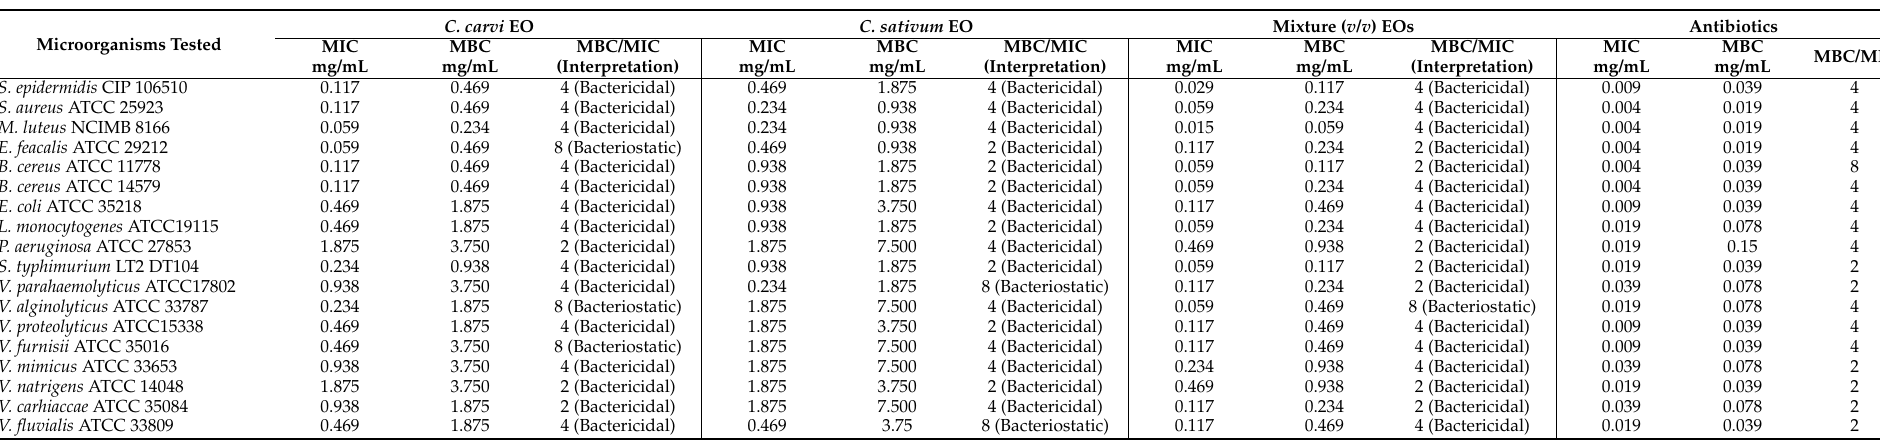
Table 5. Minimal inhibition concentration (MIC), minimal bactericidal concentration (MBC), and MBC/MIC ratio showing quantitative antibacterial activity of two EOs ( C. carvi and C. sativum ) and their mixture against human pathogenic bacteria compared to standard antibiotics (gentamycin and tetracycline). Microorganisms Tested